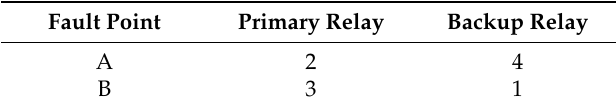
Table 1. Primary and backup relationships of the relays for Case